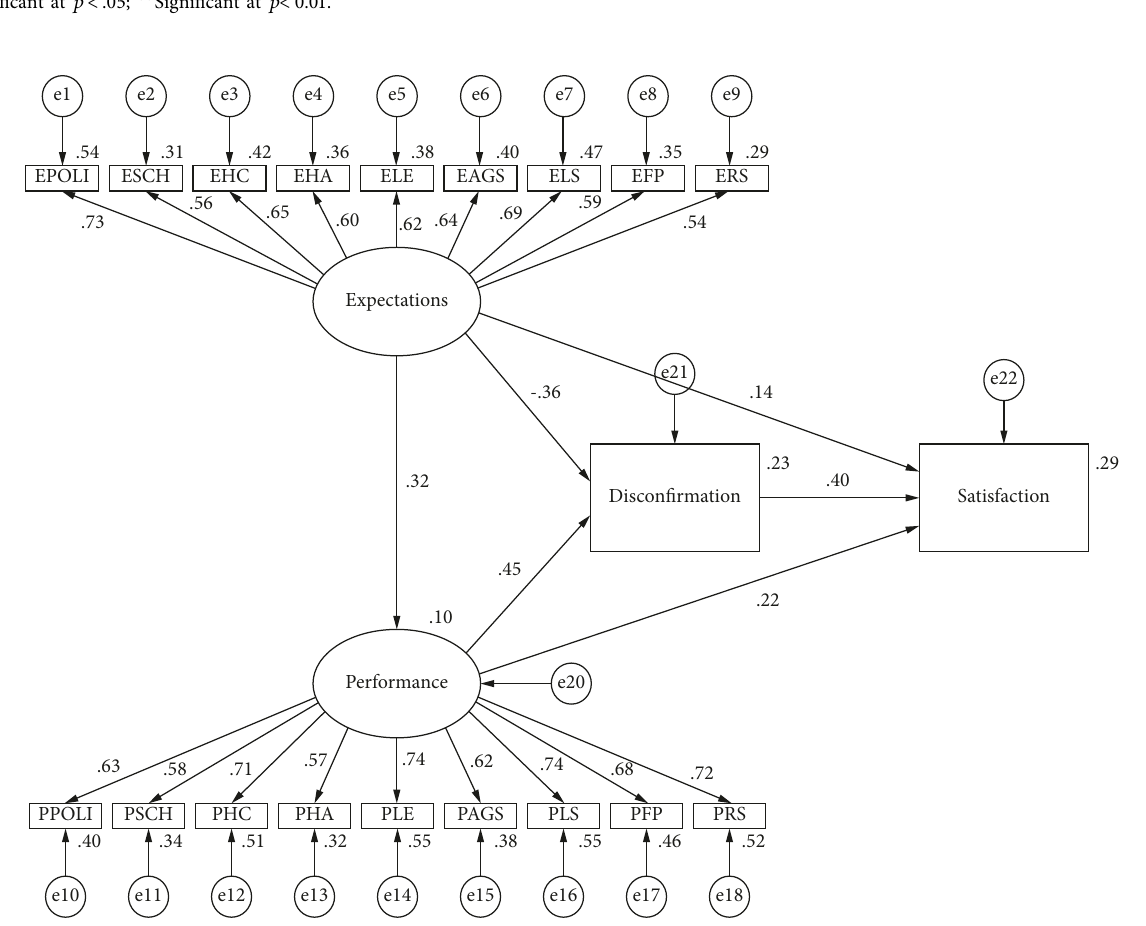
Figure 3: Model 1: the basic Expectancy Disconfirmation Model.